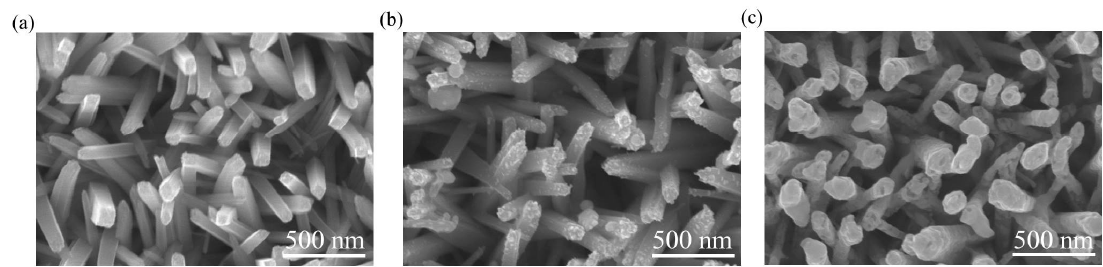
Figure 3. SEM images of various nanorods: ( a ) TiO 2 , ( b ) TiO 2 –Ag 2 O-1, ( c ) TiO 2 –Ag 2 O-2.